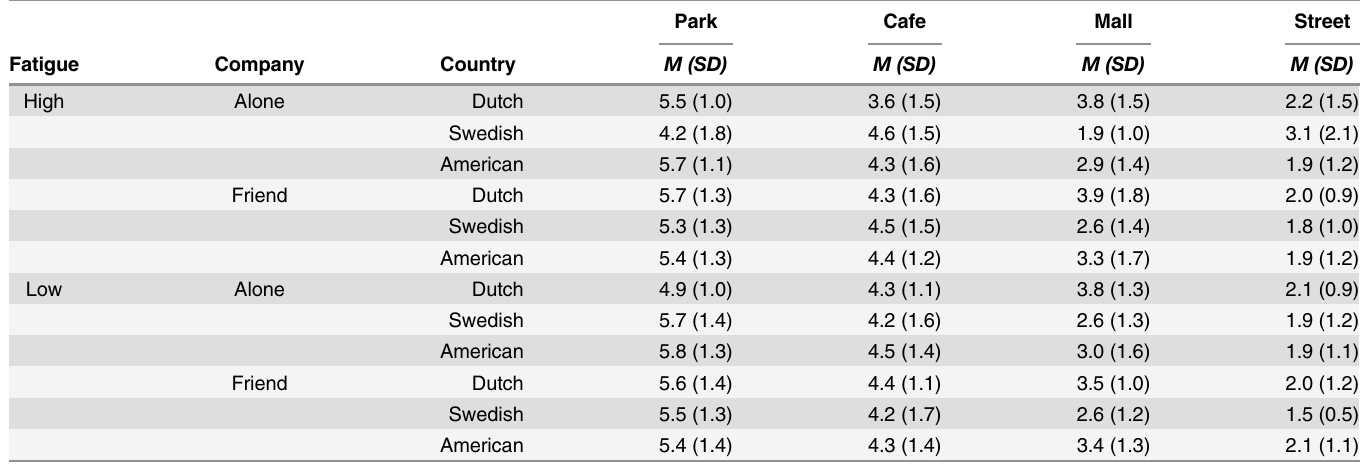
Table 5. Restoration likelihood scores (means and standard deviations) for the four settings broken out for conditions of attentional fatigue, com- pany and country.